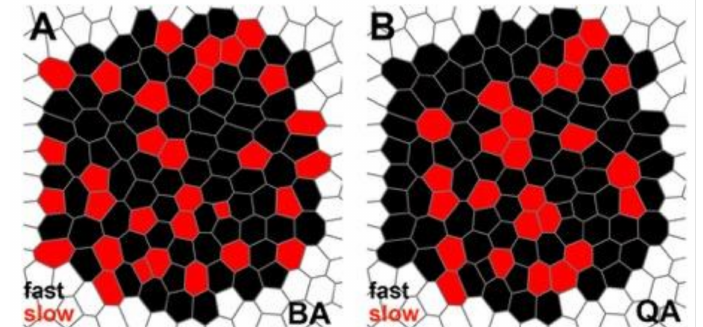
Figure 14. “Slow fibres are labelled in red and fast fibres in black. ( A ) In the BA a high tendency for slow cells to be isolated govern the organization of the tissue. This induces a homogenous distribution of both types of fibres. ( B ) In QA, there is no clear tendency in the organization. Slow fibres can appear isolated or grouped. The distribution is random,” Bag et al. [24].